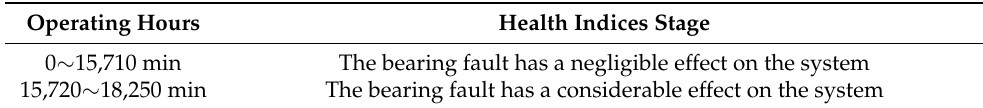
Table 4. The division of health